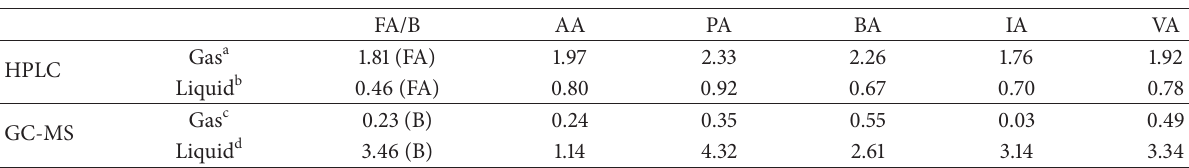
Table 5: Comparison of basic QA parameters in CC analysis between different standard phases using both HPLC and GC methods. (a) Precision (relative standard error (RSE): in %)